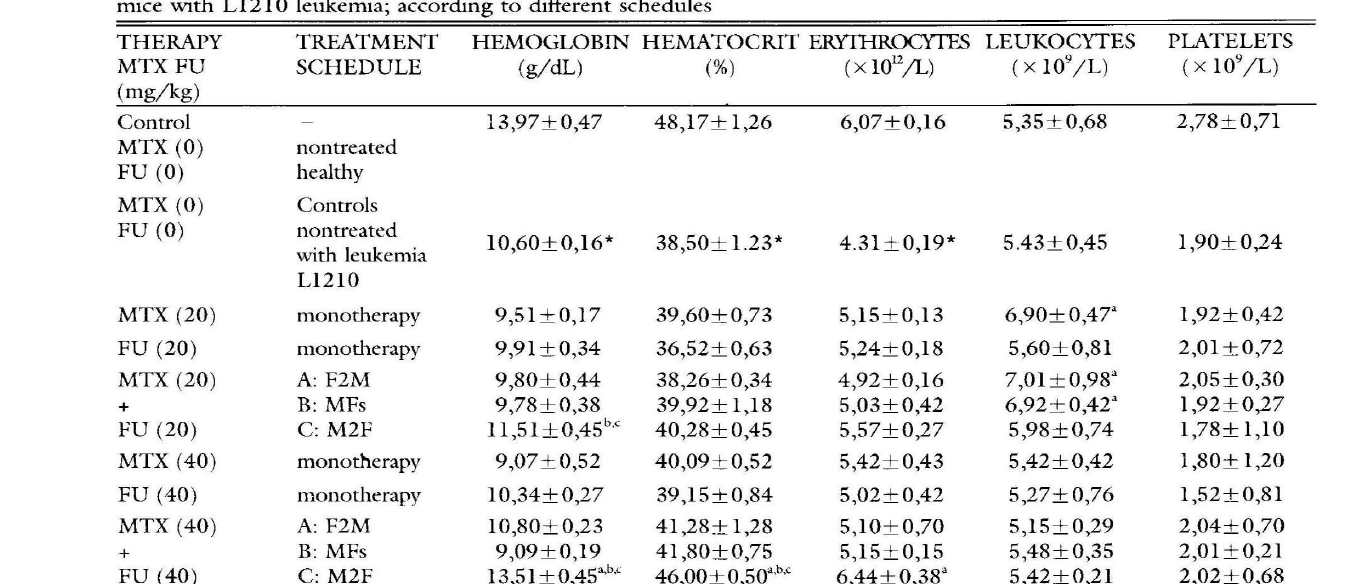
Table 2. Effect of combined MTX/FU therapy on the values of peripheral blood morphotic elements in healthy BDF mice with LI210 leukemia; according to difierent schedules THERAPY TREATMENT HEMOGLOBIN HEMATOCRIT ERYIHROCYfF.5 LEUKOCYTES